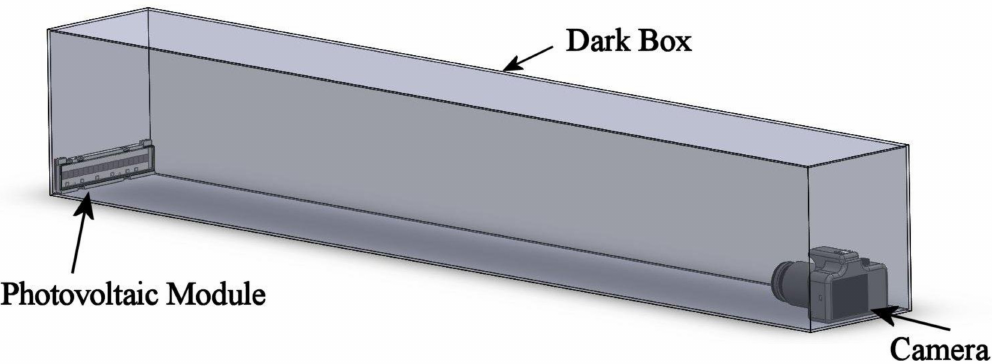
Figure 1. Test bench for electroluminescence tests.